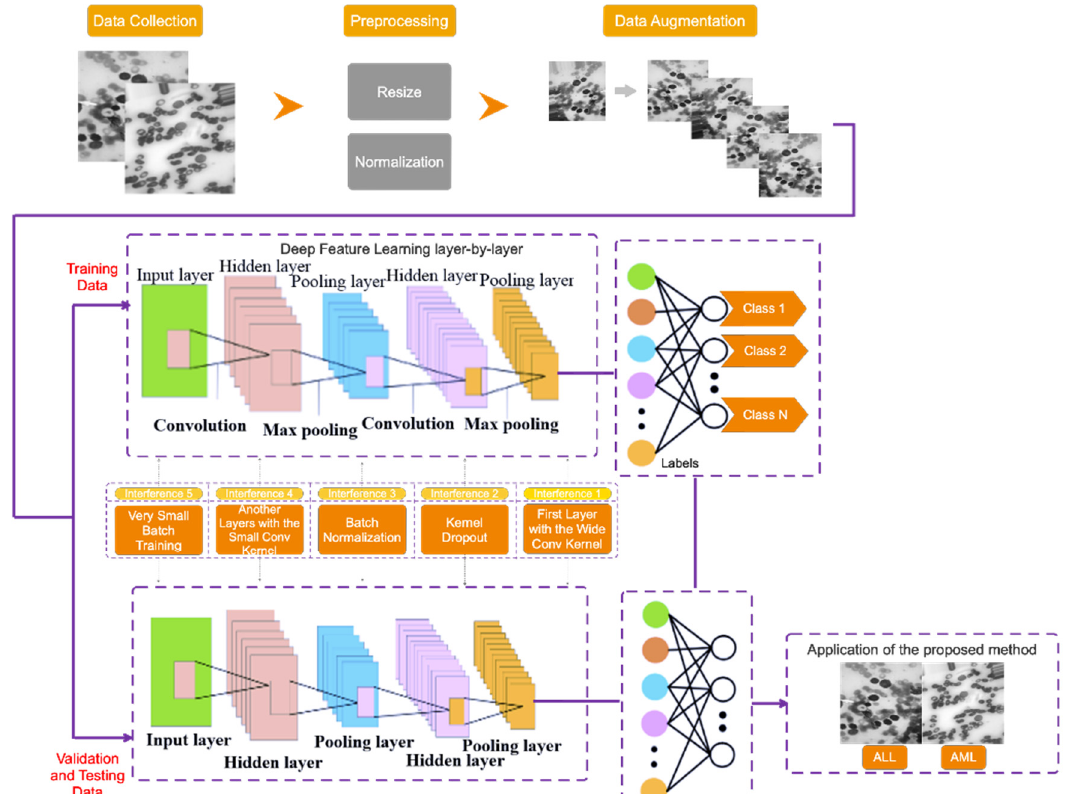
Figure 1. The proposed method block